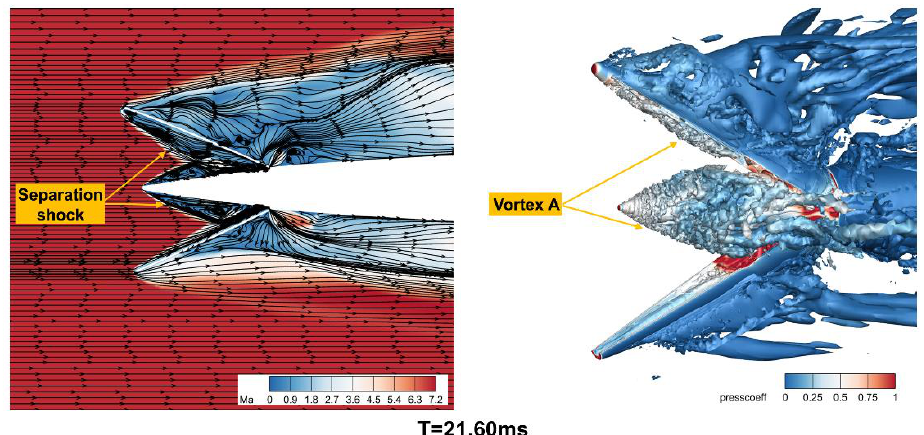
at Time = 20.70 ms.